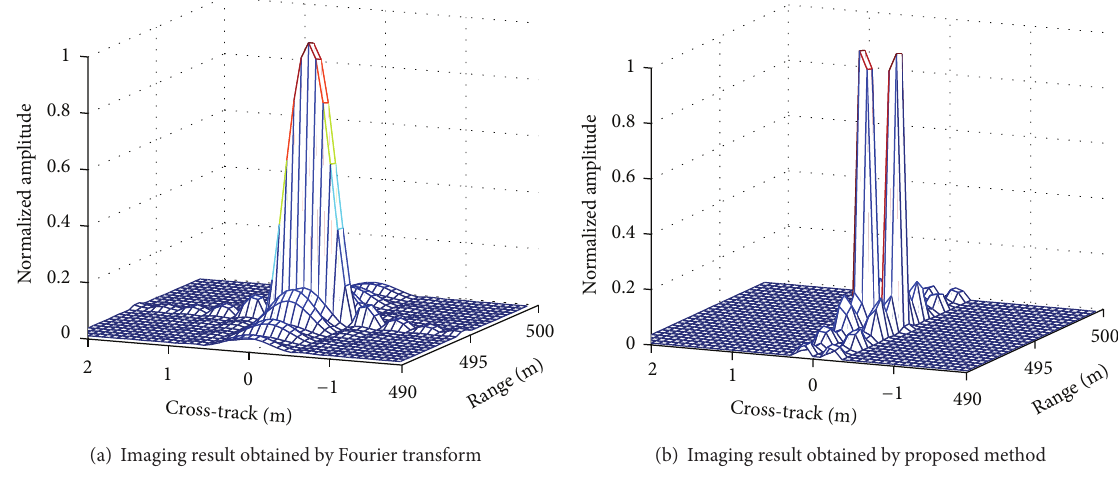
Figure 6: Comparison of the range-cross track imaging results of down-looking MIMO array SAR.